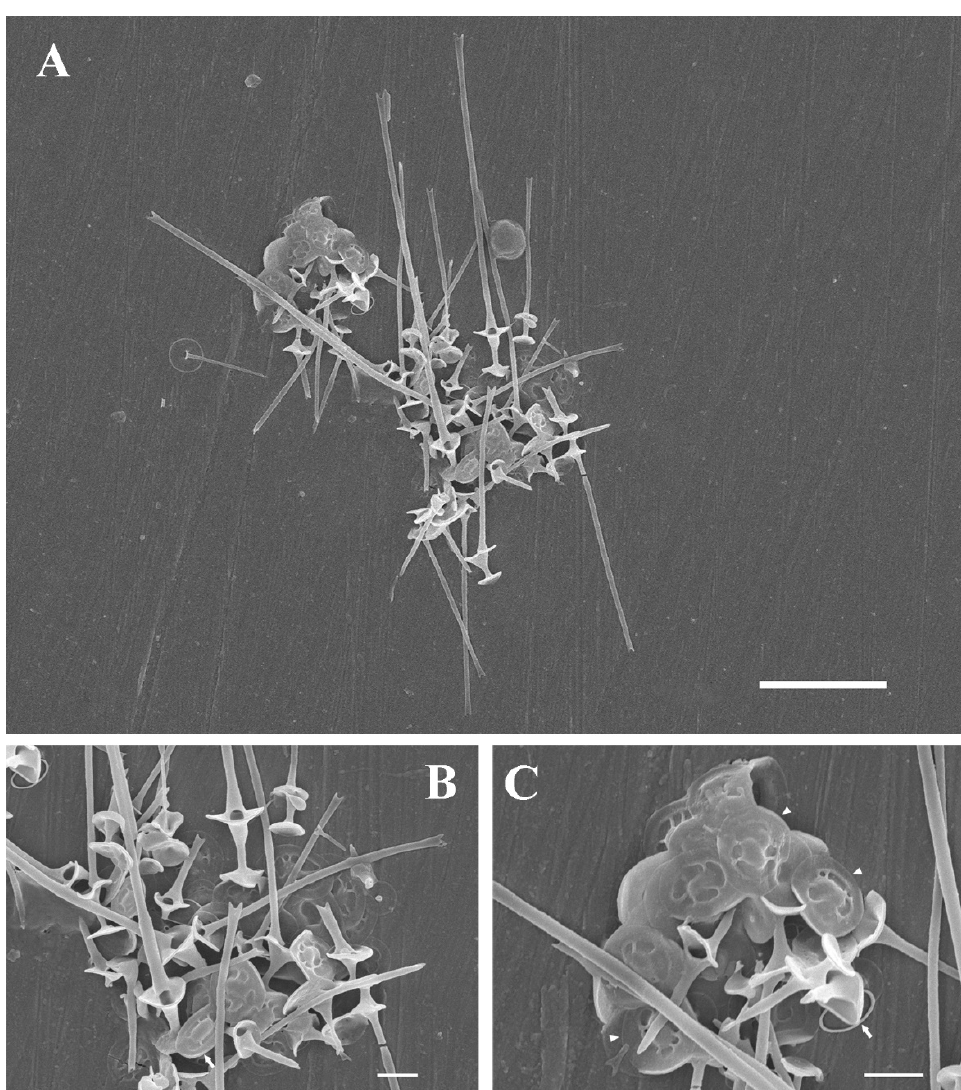
Figure 1. ( A – C ) Chrysosphaerella septentrionalis sp. nov., SEM. ( A ) General view; ( B ) close-up view of the scales. Note the oval plate-like scale; ( C ) close-up view of the subcircular (arrowhead) and the oval unpatterned scales (arrow). Scale bars: ( A ): 10 µm; ( B , C ): 2